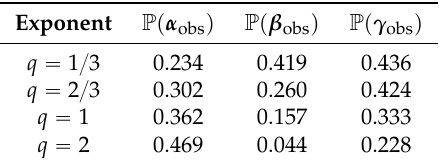
Table 3. Display of the probabilities of our observables for different values of the power law